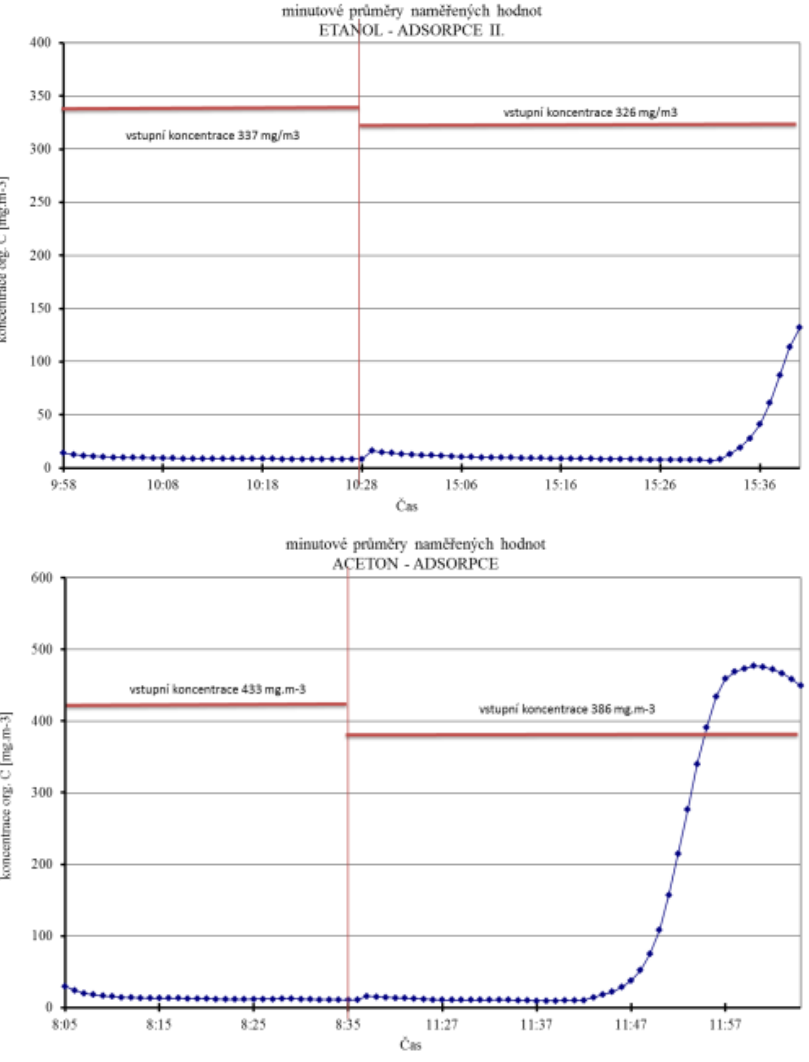
Figure 19. Permeation of vapor: vapors of heptane, acetone, and ethanol with porous SiO 2 nanofibers, prepared by paper-making technology. Table 5. Results of permeation evaluation of selected organic vapors through a thin layer of porous SiO 2 nanofibers.